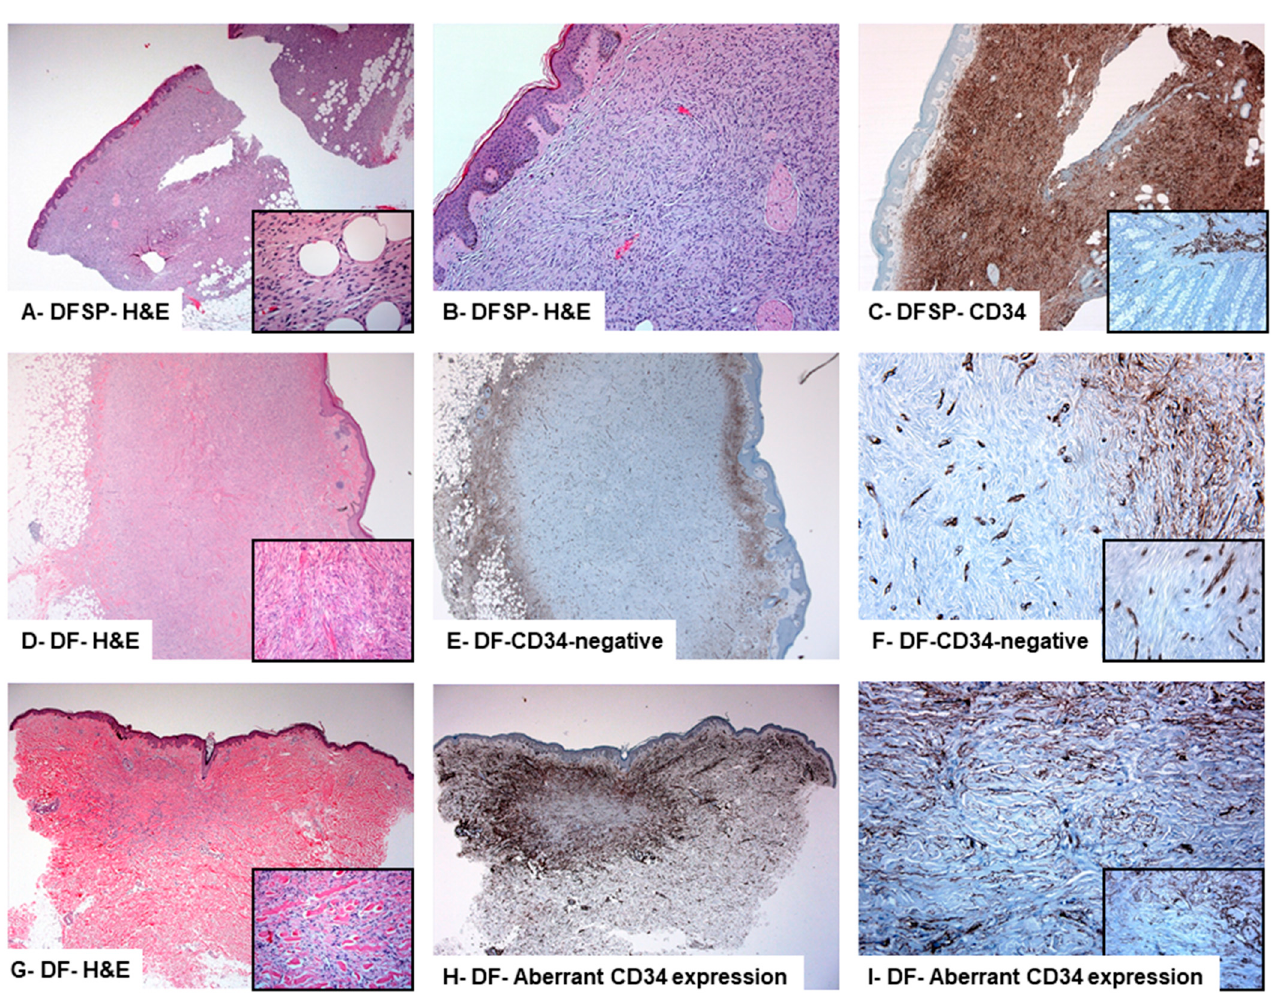
Figure 2. CD34 expression in dermatofibrosarcoma protuberans and dermatofibroma. Table 1. Data from individual studies of dermatofibroma with aberrant expression of CD34 protein.